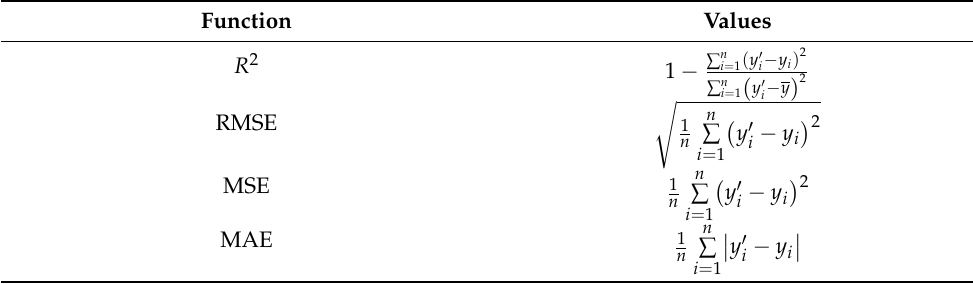
Table 8. Statistical criteria to evaluate the accuracy of DNN